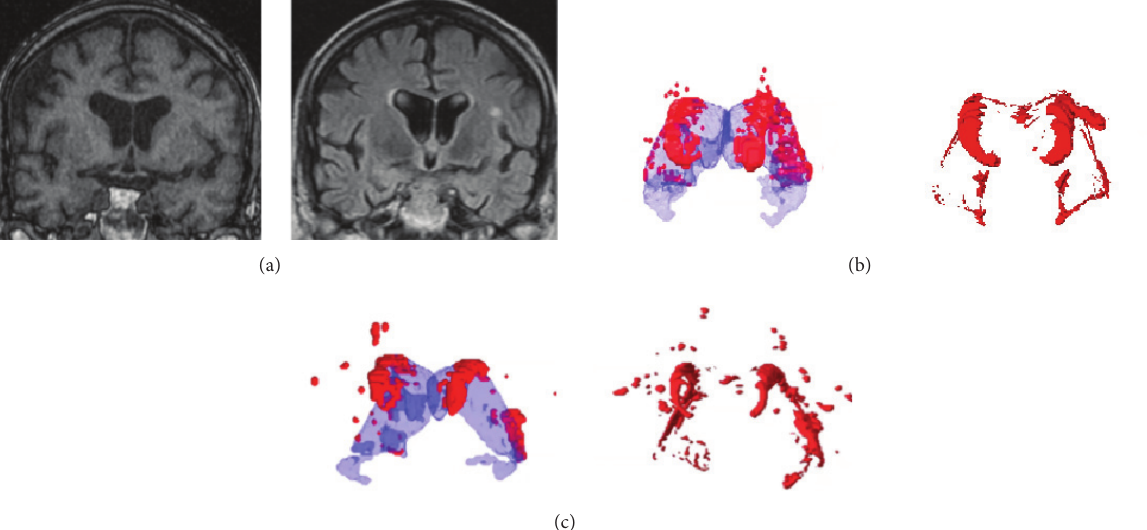
F 6: 3D visualizations and MRI images of WML assessed by FreeSurfer and in manual volumetry. (a) MRI images of a dementia patient. e le image shows a T1 original image used in the FreeSurfer assessment where there are FreeSurfer �ndings of punctate WML. e FLAIR image to the right in the corresponding position contains a large punctate WML patch close to the superior cortical part of the le insula which is hardly visible in the T1 image. (b) e same dementia patient with WML burden (in red) at approximately the same manually extracted high-burden WML volume as the control subject. FreeSurfer assessment is shown to the le with the lateral ventricles visualized in transparent blue, and manual volumetry is shown to the right. (c) Control subject with WML burden (in red) at approximately the same manually extracted high-burden WML volume as the dementia patient. FreeSurfer assessment is shown to the le with the lateral ventricles visualized in transparent blue. Manual volumetry is shown to the